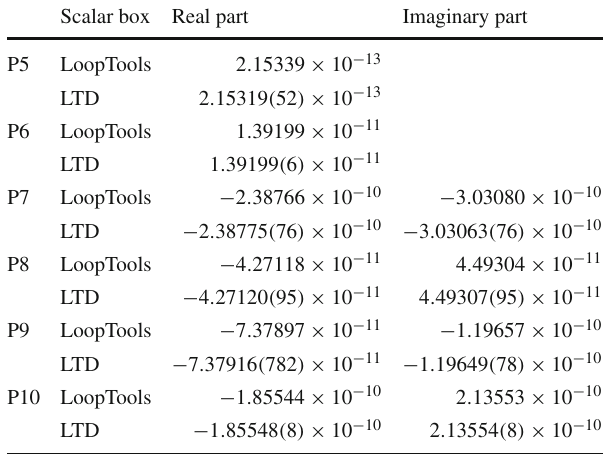
Scalar box Real part